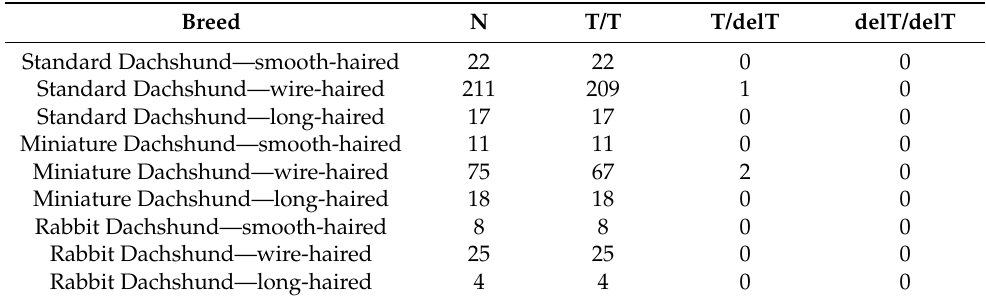
Table 2. Genotypic distribution of FGA rs1152388481 variant in controls including 393 healthy Dachshunds (N = number of animals, T = wildtype allele, delT = deletion of